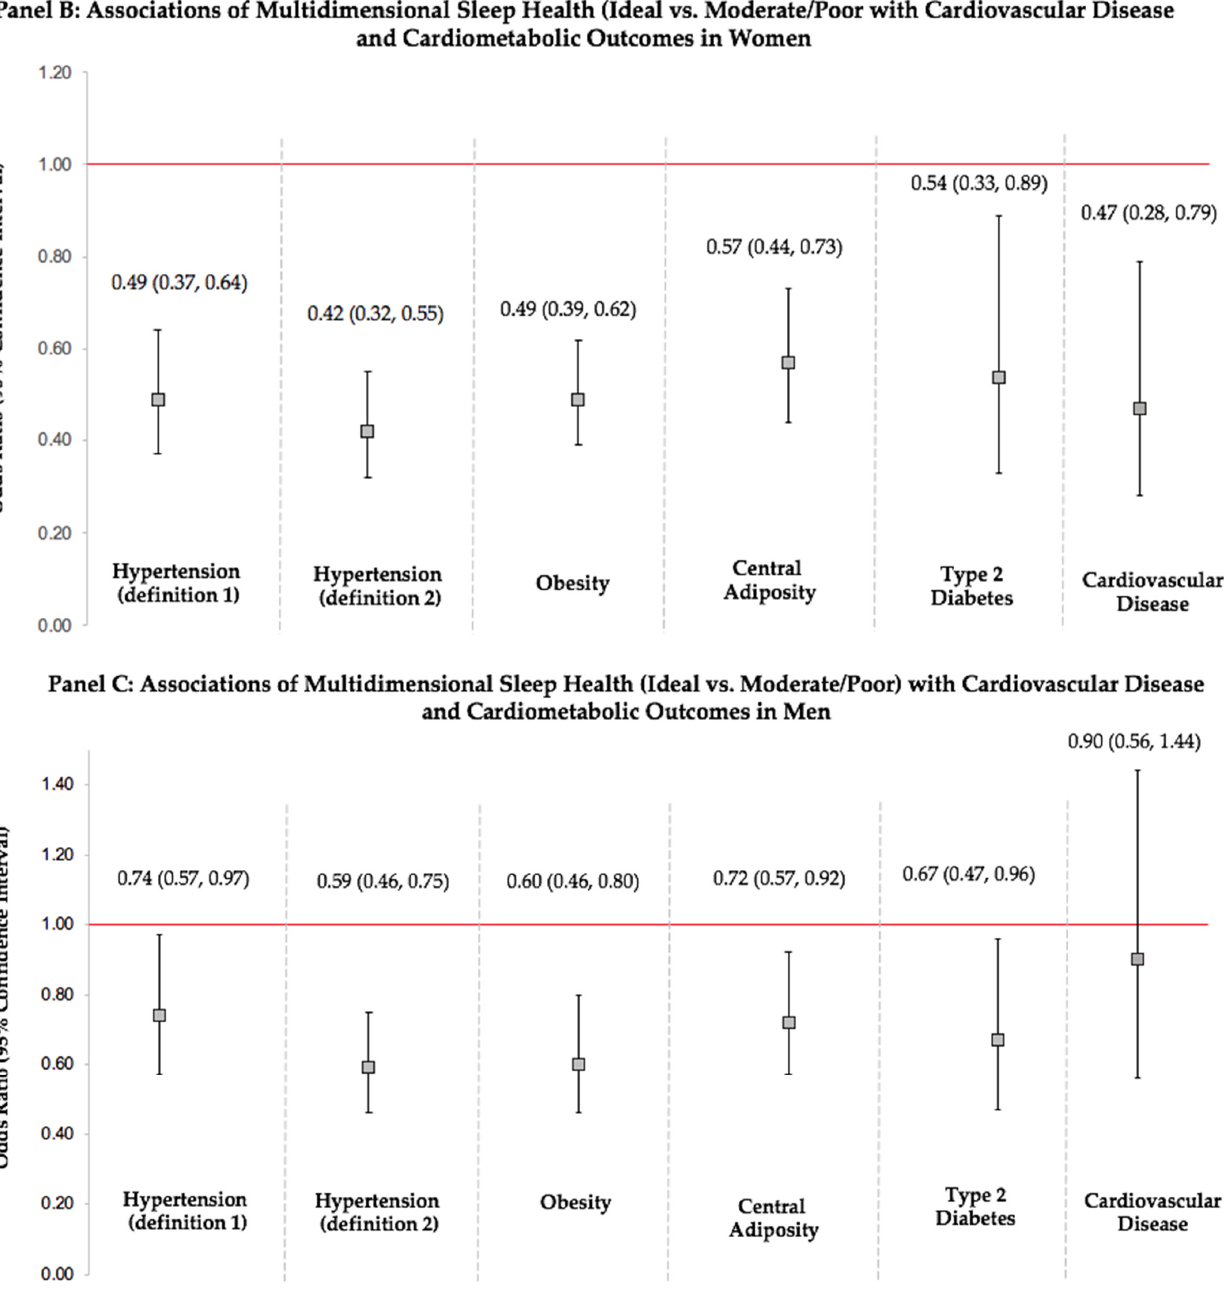
Figure 1. Associations of Multidimensional Sleep Health with Prevalent Cardiovascular Disease and Cardiometabolic Outcomes in the Overall Sample and By Sex (n = 4555) . Caption. Associations of ideal vs. moderate/poor multidimensional sleep health with prevalent cardiovascular disease and cardiometabolic outcomes from logistic regression models. All models were adjusted for age, sex, race/ethnicity, education, and marital status. Obesity is defined as a BMI ≥ 30 kg/m 2 ; central adipos- ity is defined as a waist circumference > 88 cm in women and > 102 cm in men; and type 2 diabetes